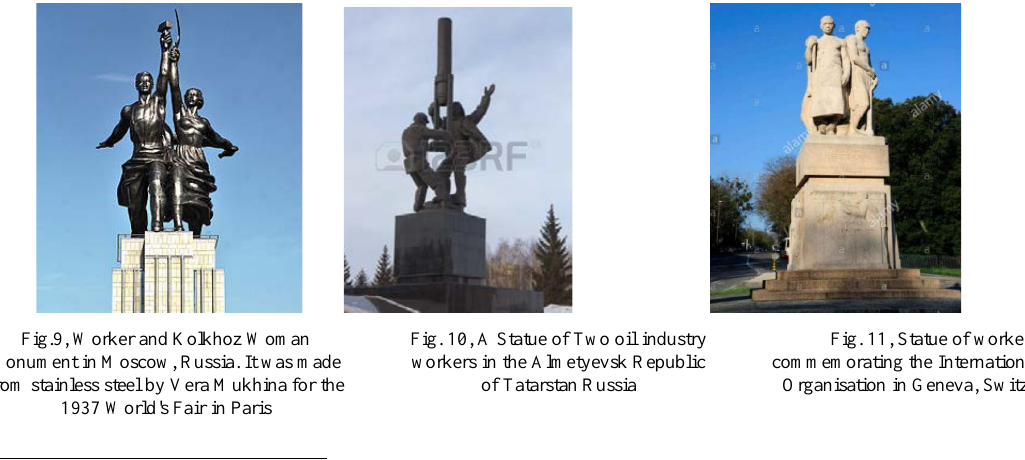
Fig.9, Worker and Kolkhoz Woman monument in Moscow, Russia. It was made from stainless steel by Vera Mukhina for the 1937 World's Fair in Paris